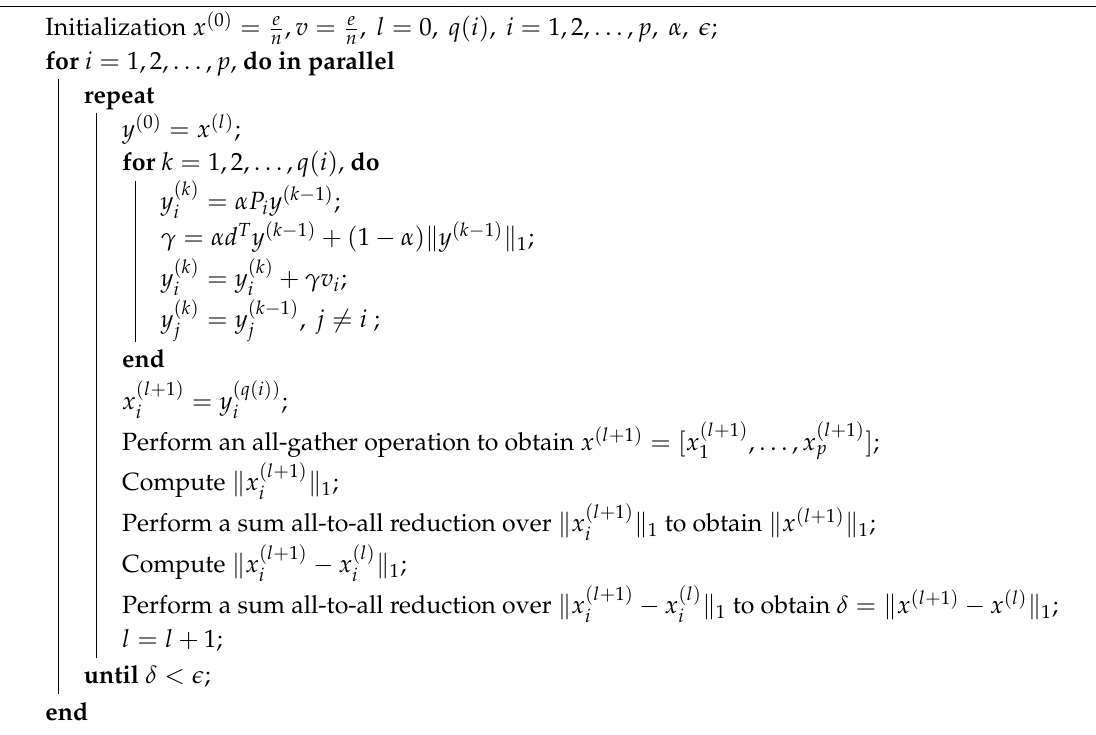
Algorithm 3: Parallel non-stationary algorithm for solving